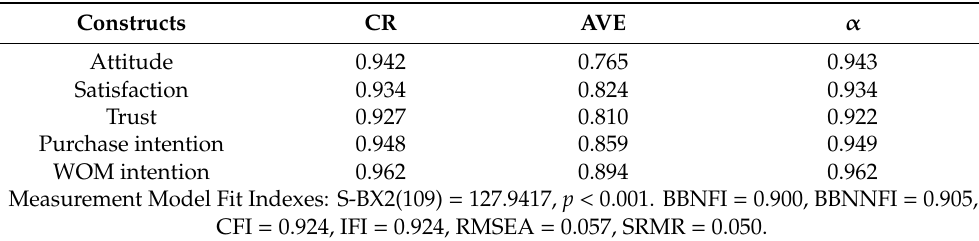
Table 3. Reliability and validity